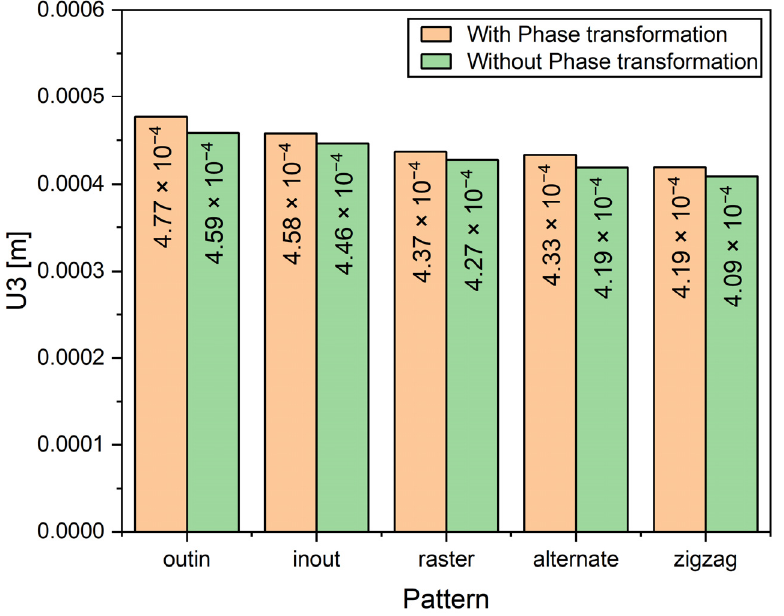
Figure 15. Comparison of maximum deflection of different deposition patterns after clamp